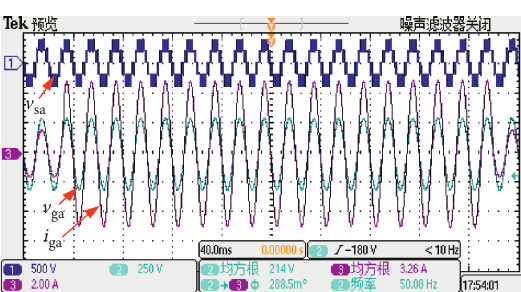
Figure 18: CHB dynamic operating waveforms.